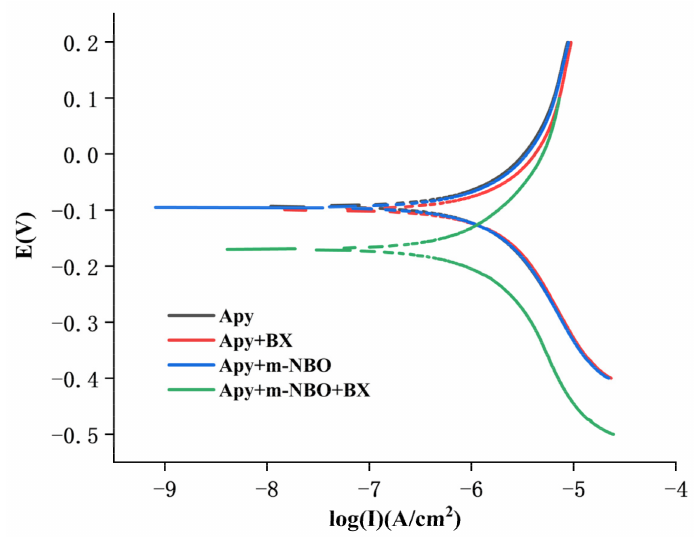
Figure 10. Tafel curves of the arsenopyrite electrode in the presence of m-NBO and NaBX at pH = 9;